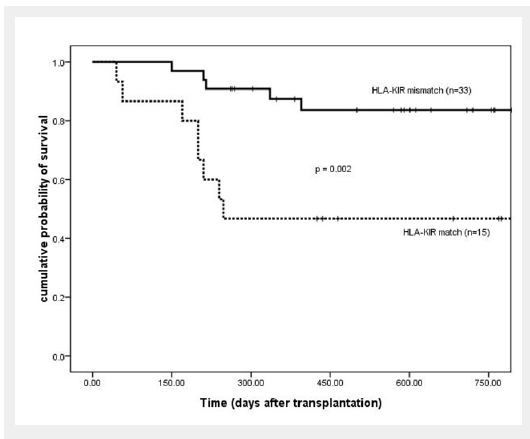
Overall survival of patients based on HLA-KIR match/mismatch group. HLA =human leukocyte antigen; KIR = killer immunoglobulin-like receptor.